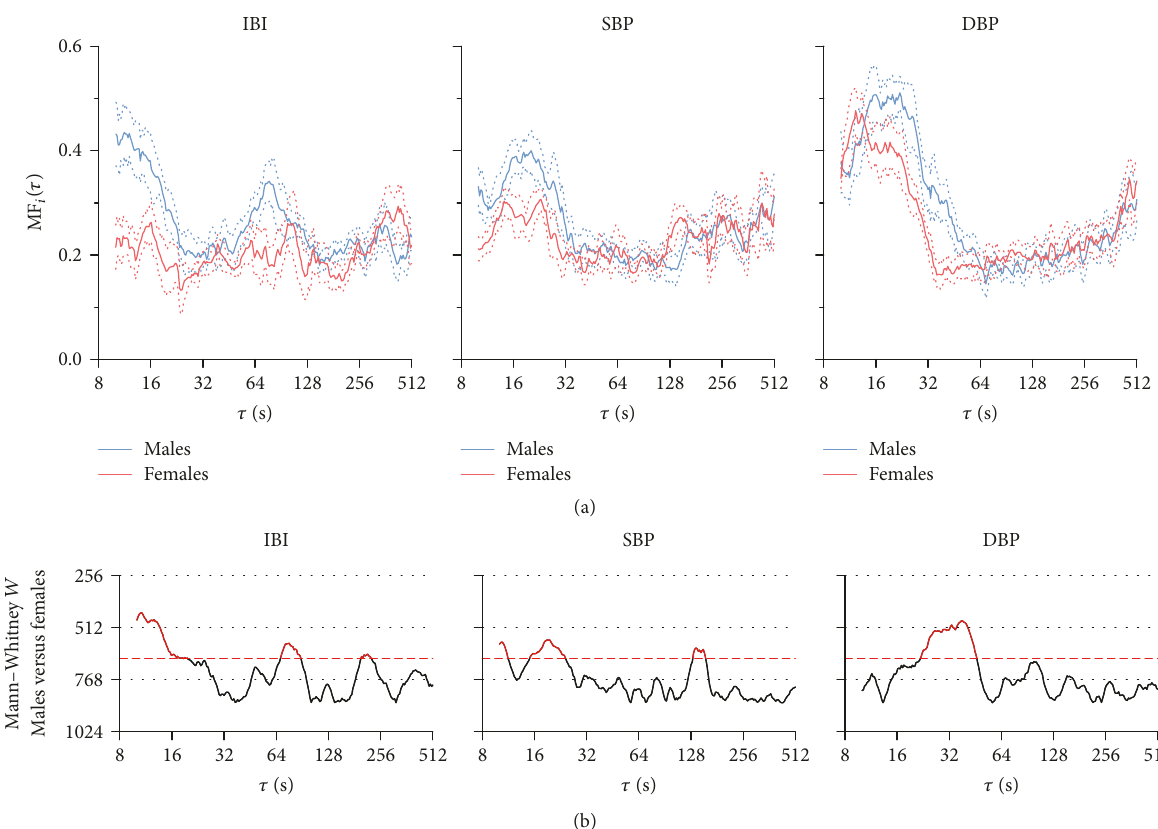
Figure 8: Multifractal index 𝑀𝐹 𝐼 (𝜏) : comparison by sex . (a) Median ± standard error of the median; (b) 𝑊 statistics of Mann–Whitney tests for comparing males ( 𝑁 = 42 ) and females ( 𝑁 = 42 ), as function of 𝜏 . Dashed horizontal lines represent the 5% significance threshold; 𝑊 values above the threshold (red dots) indicate differences significant at 𝑝 < 5